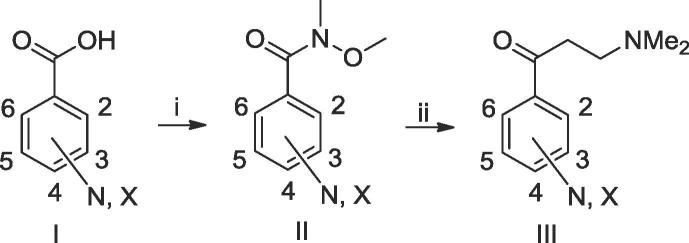
Synthesis of new pyridyl 3-(dimethylamino)propan-1-one C/D units. Reagents and conditions: (i) COCl2, cat. DMF, DCM, then MeNH(OMe). HCl, pyridine; (ii) vinylMgBr, then Me2NH, THF.